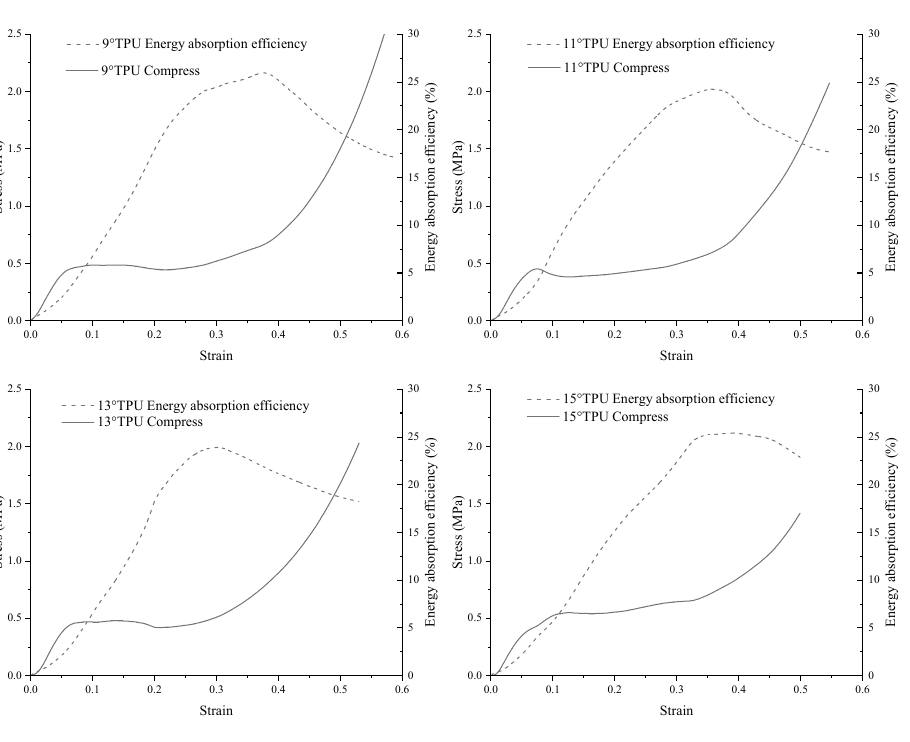
Figure 14. Stress-strain curves and energy absorption efficiency curve of four bionic models.